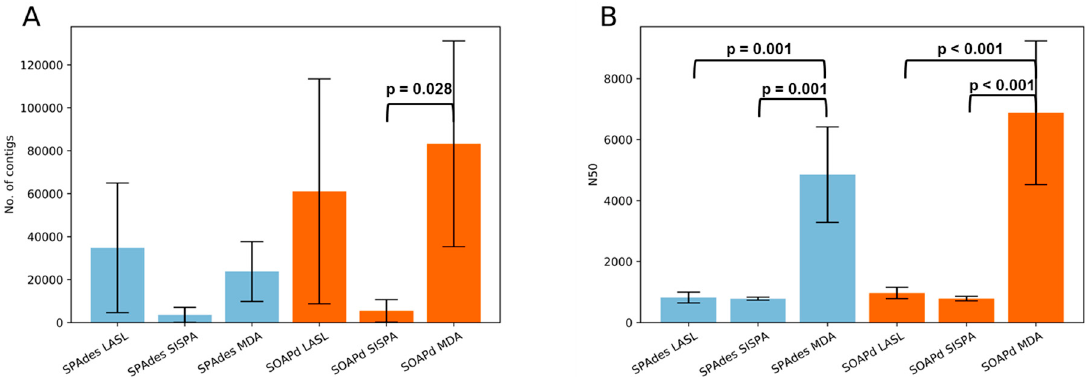
Figure 3. Number of contigs ( A ) and N50 ( B ) produced by sequence library preparation methods and assembly tools. Differences between library preparation methods were tested using analysis of variance (ANOVA). SOAPd: SOAPdenovo-Trans, NASL: non-amplified shotgun library, LASL: linker amplification shotgun libraries, SISPA: single-primer amplification, MDA: multiple displacement amplification.